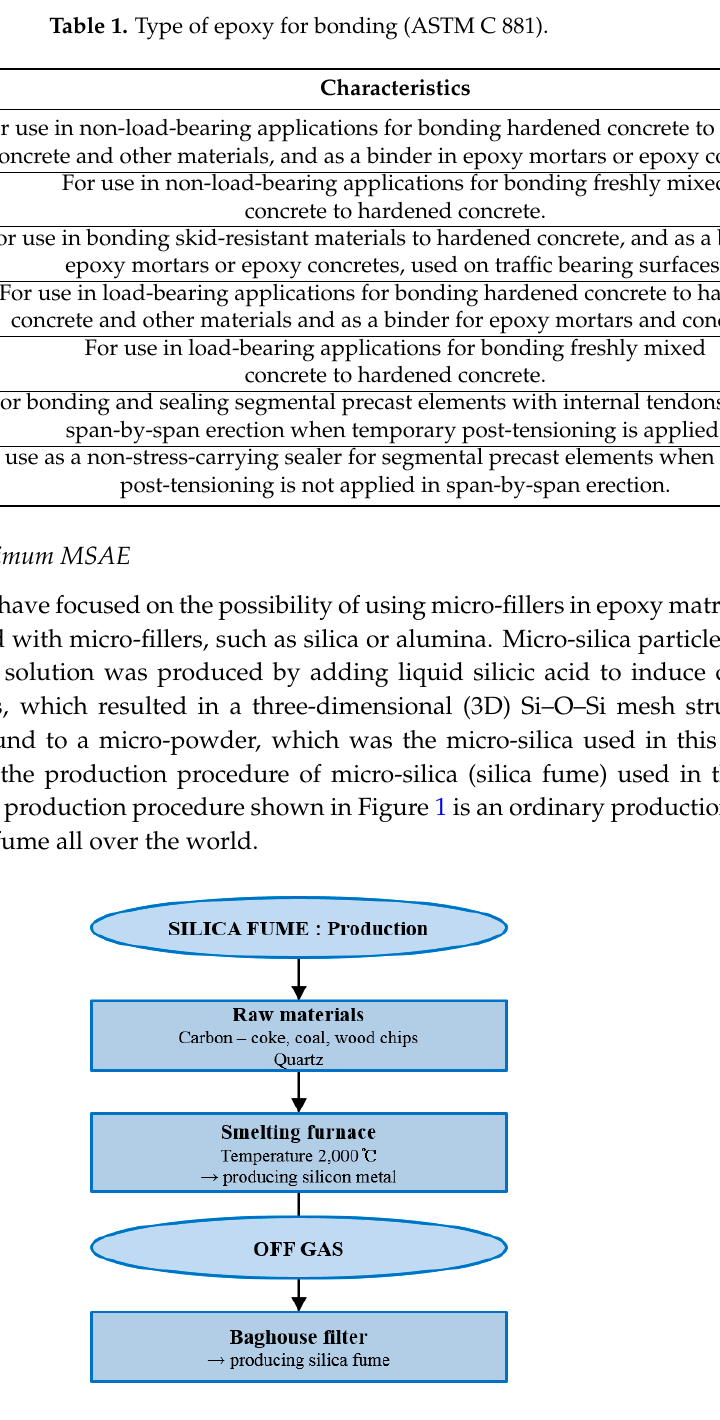
Figure 1. Preparation procedure of micro-silica [14].